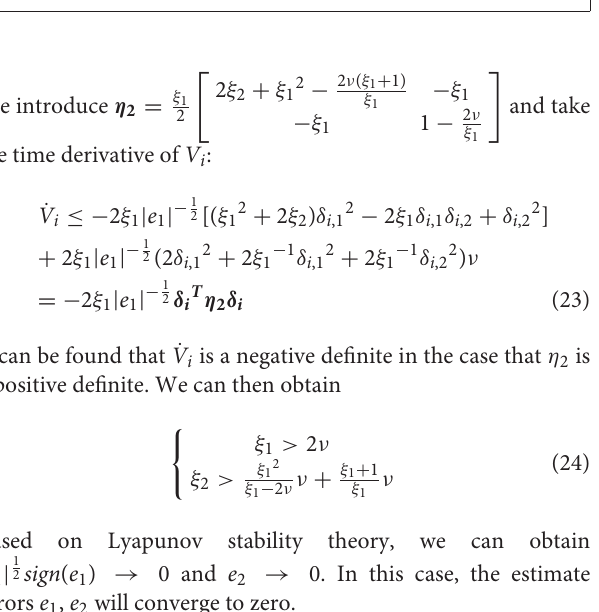
FIGURE 3 | Control schematic of the overall hexacopter UAV